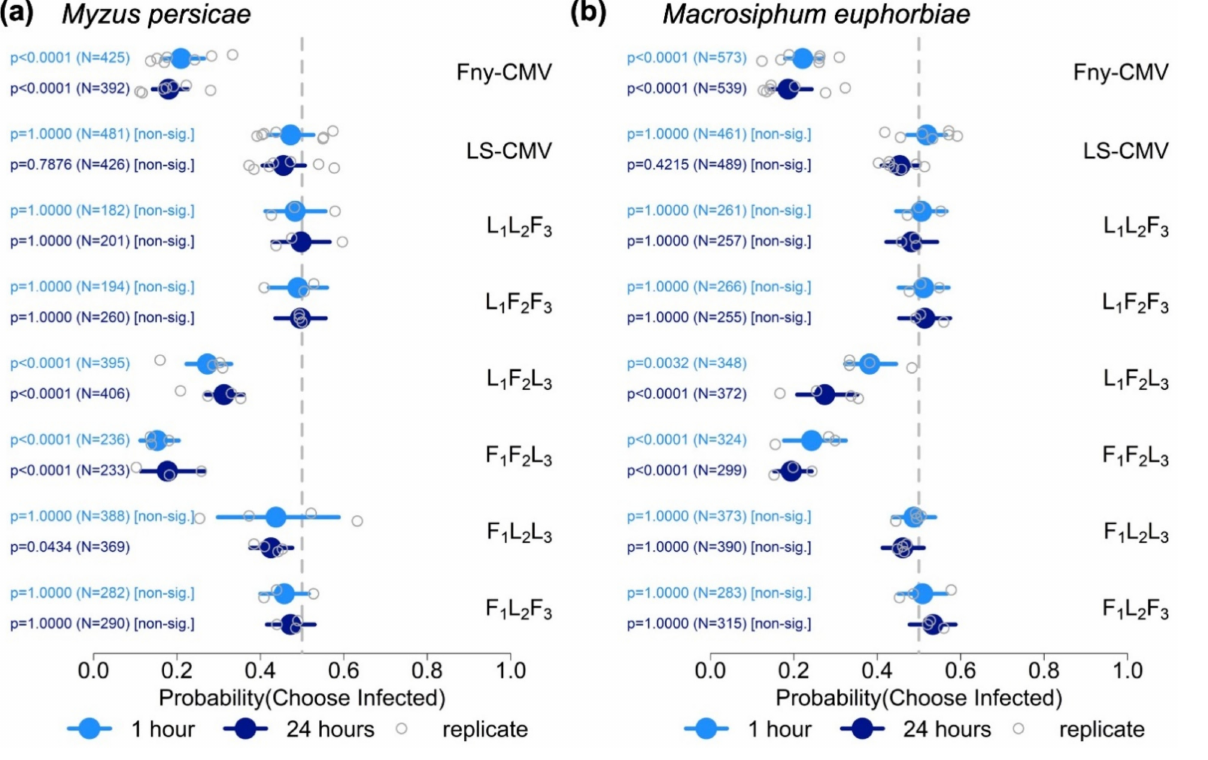
Figure 5. Summary of free-choice aphid preference assays for ( a ) Myzus persicae and ( b ) Macrosiphum euphorbiae ) using mock-inoculated tomato plants or plants infected with wild-type LS-CMV, wild-type Fny-CMV or inter-strain pseudorecombinant (reassortant) viruses (at 21 days post-inoculation). The x - axis shows the range of the 95% credible interval of the probability of settlement of aphids on infected plants at 1 and 24 h after aphid release, with values for each independent experiment (replicate). The total number of aphids (N) investigated for each comparison is indicated and statistical significance or non-significance determined using binomial tests. The vertical grey dotted lines indicate a probability of 0.5 of settlement on infected versus mock-inoculated plants, i.e., no settlement